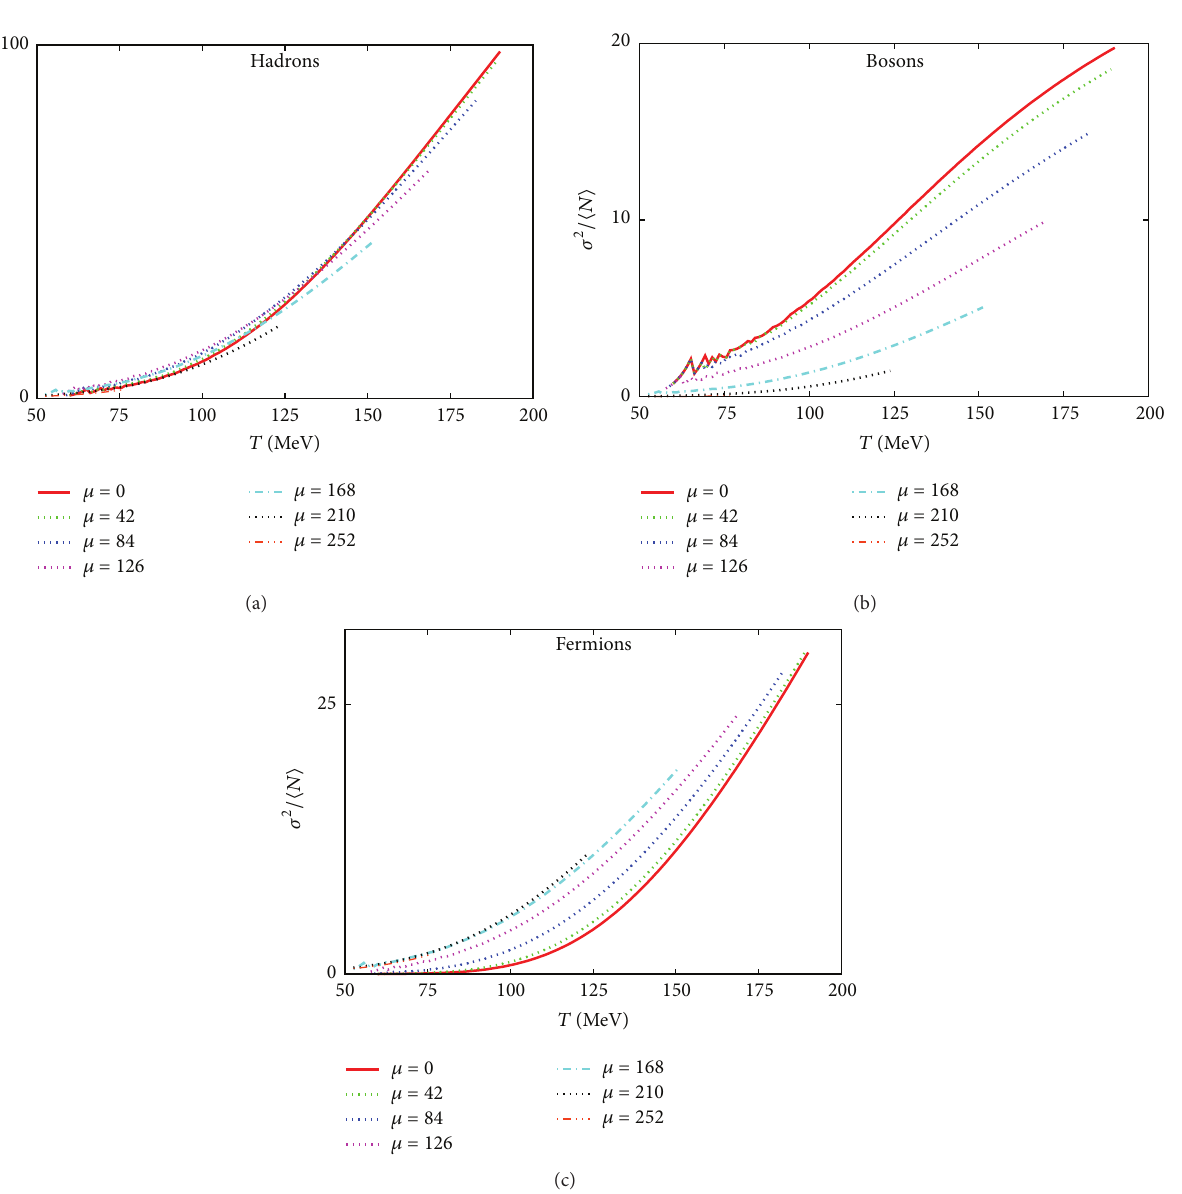
Figure 4: The ratio 𝜎 2 /⟨𝑁⟩ is given depending on 𝑇 at different chemical potentials 𝜇 for hadronic (a), bosonic (b), and fermionic (c) resonance